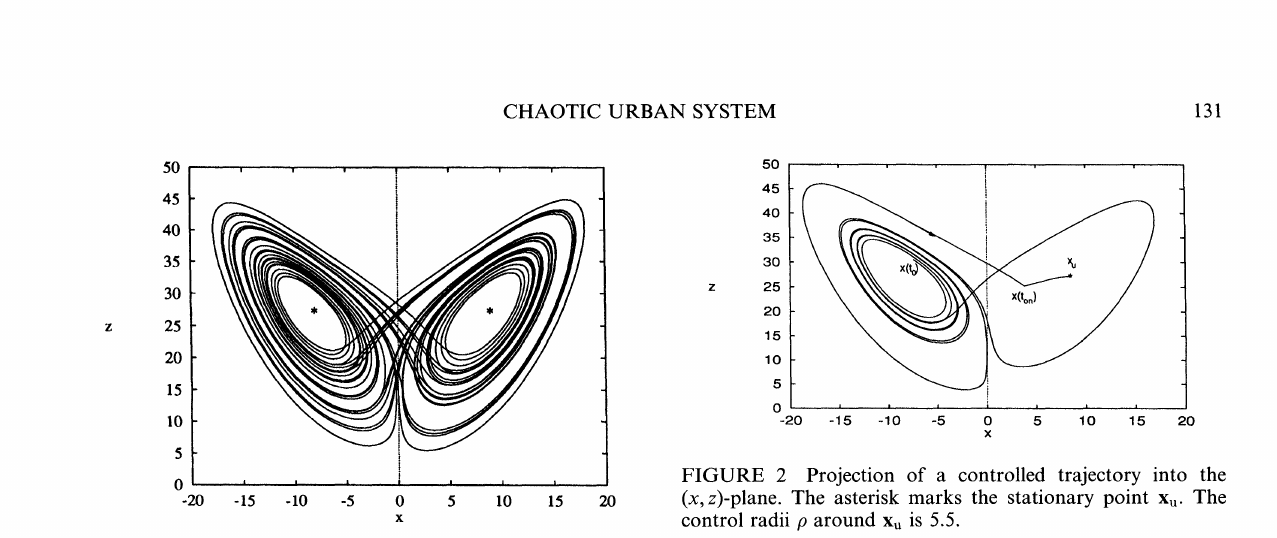
FIGURE 2 Projection of a controlled trajectory into the (x,z)-plane. The asterisk marks the stationary point xu. The control radii p around xu is 5.5.